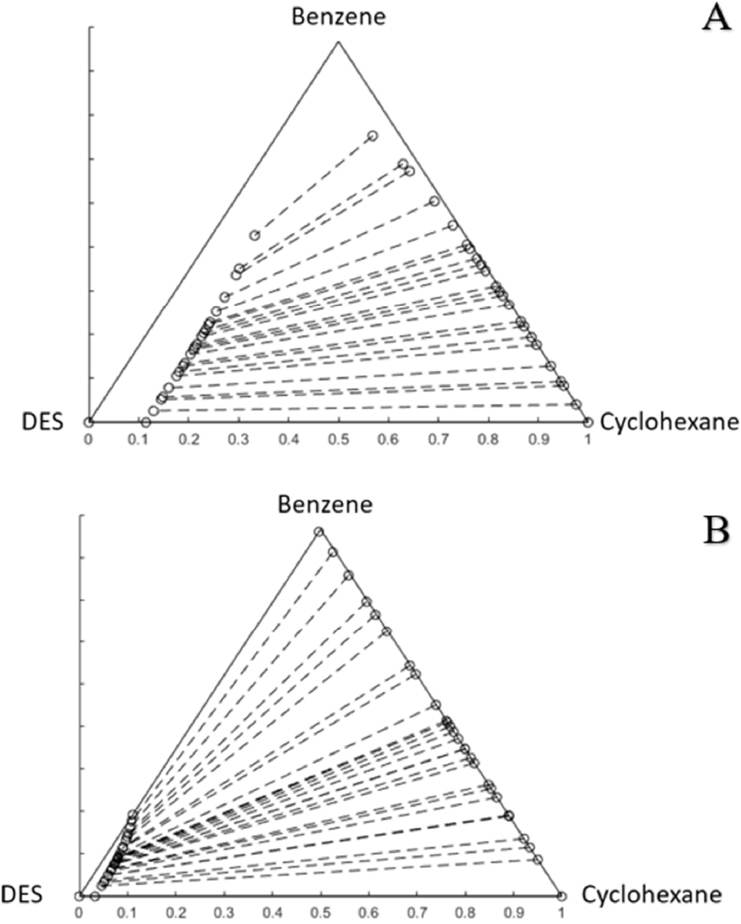
Figure 3. ( A ) Predicted LLE of N 4444 Br:EG (1:2), Cyclohexane and Benzene at 25 °C. Concentrations in Mass Fraction; ( B ) Predicted LLE of METPB:Gly (1:3), Cyclohexane and Benzene at 25 °C. Con- centrations in Mass Fraction.